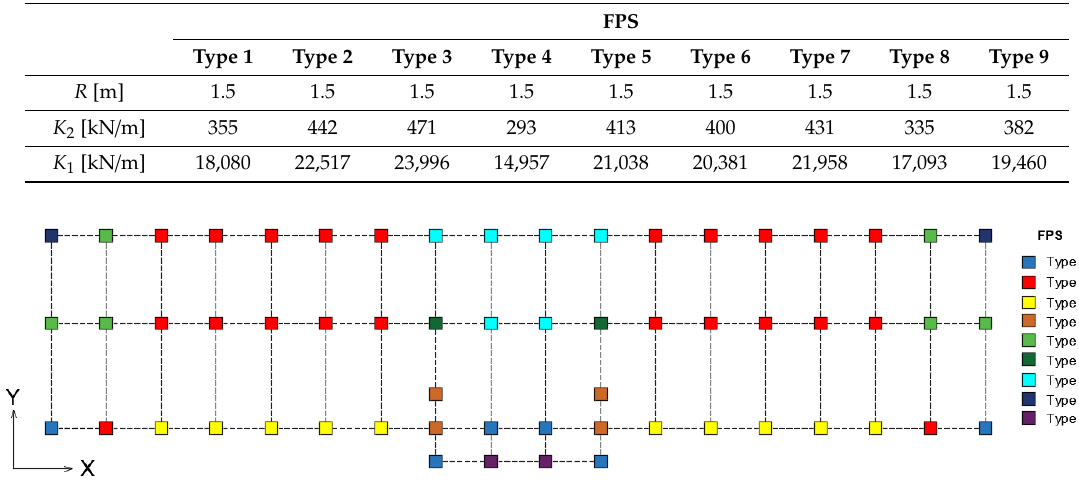
Figure 6. Non ‐ linear numerical models for FB ( a ) and BI ( b ) structure using SAP 2000 [25]. 4.2. Evaluation of the Seismic Demand and Non-Linear Dynamic Analyses The evaluation of the seismic demand in terms of elastic pseudo ‐ acceleration S a is performed considering the elastic design response spectrum related to 50 years reference period associated to nearly ‐ collapse limit state according to [2] with reference to the seismic hazard site. The elastic response spectra have been defined adopting two different damping ratios as shown in Figure 7, in particular: ξ = 5% for the fixed ‐ base (FB) NLN model and ξ = 2% as suggested by [17] for the base ‐ isolated (BI) NLN model [17]. In general, the value of ξ = 5% is widely accepted for the dynamic analysis of FB RC structures [17]. With reference to the BI structure, the value of ξ is lower than the one related to the FB structure as the superstructure moves on the isolation level similarly to a rigid body. For instance, most of the energy in the BI structure is dissipated by hysteretic damping which is provided by the isolator devices. A value of ξ = 2% for BI RC structures is recognized according to common practice and literature references [3,17].